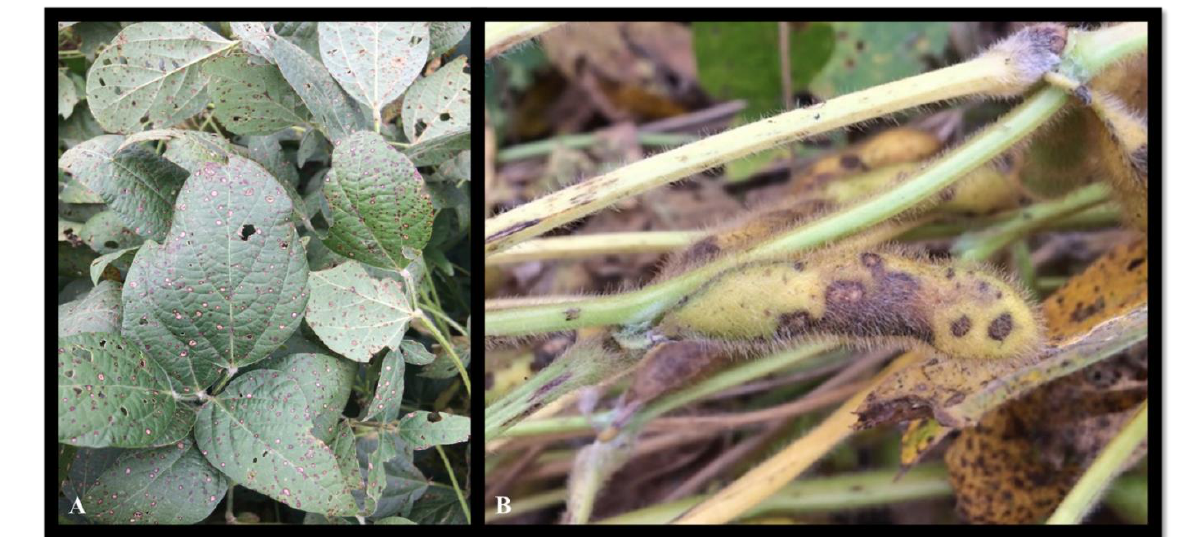
Figure 1. ( A ) Symptoms of frogeye leaf spot on soybean leaves. Image: X. Phillips. Taken 09-06-2018 in Lewis, IA, USA. ( B ) Symptoms of frogeye leaf spot on a soybean pod. Image: X. Phillips. Taken 09-13-2018 in Lewis, IA. USA.